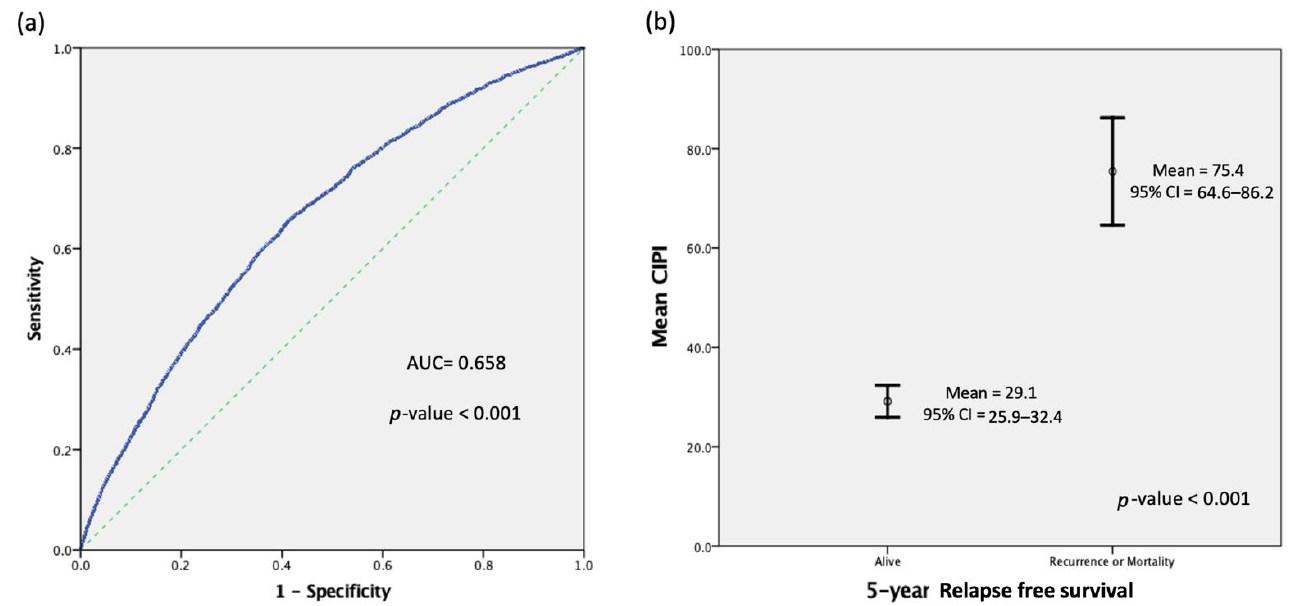
Figure 1. ( a ) Receiver operating characteristic (ROC) curve analysis of the cancer-inflammation prognostic index (CIPI) for five-year relapse-free survival (RFS) in stage I–III colorectal cancer (CRC). ( b ) Mean CIPI of patients alive and with recurrence or mortality during five-year follow-up. AUC = area under the curve; CI = confidence interval. Table 1. Demographic characteristics of patients based on the